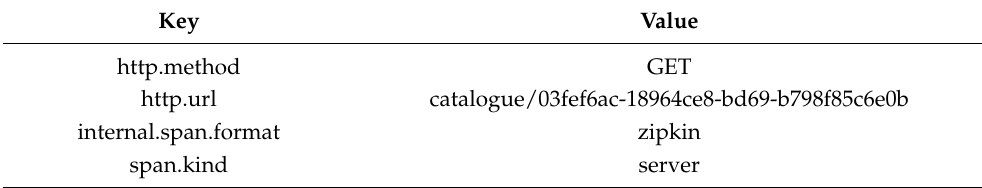
Table 3. Span tags in a span of Catalogue service. The span ID is 7b5af686fc795d70 and span name is GET/catalogue/{id} .